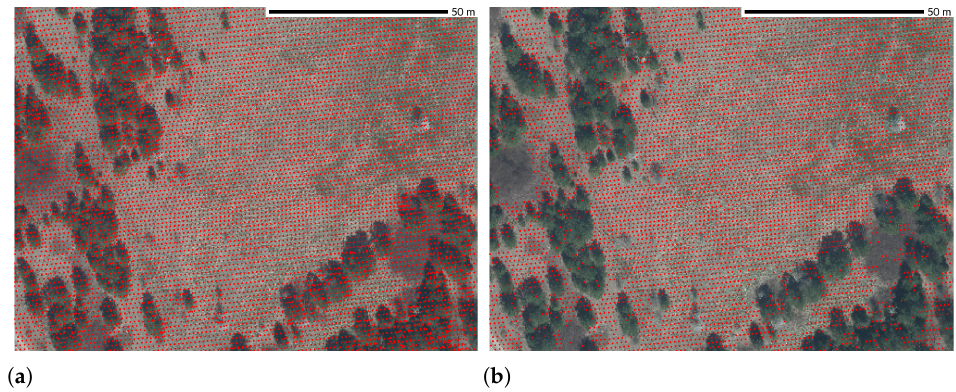
Figure 12. Horizontal point pattern in vegetated and nonvegetated areas: ( a ) Points from all returns had a regular pattern in open areas combined with irregular distributions in the vegetated areas. ( b ) Classified ground points in areas without vegetation had the original pattern, while in the areas with vegetation the distribution is much sparser. Dataset: NC Floodplain Mapping Program 2015 [42].